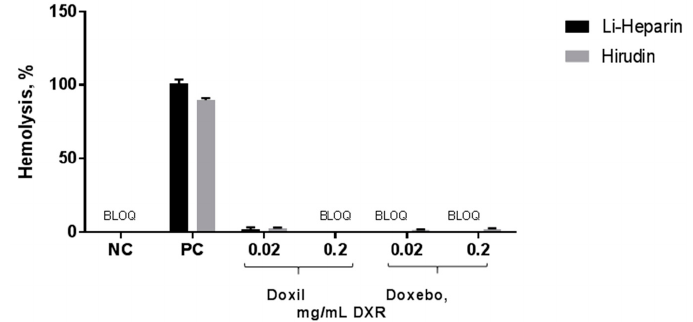
Figure 2. Hemolysis assay. Various, clinically relevant concentrations of Doxil and Doxebo were tested in the hemolysis assay in order to estimate their potential effects on the integrity of red blood cells. Three independent samples were prepared for each nanoparticle concentration and analyzed in duplicate (%CV < 20). Shown is mean ( n = 3) ± SD. Triton X-100 was used as a positive control (PC). PBS was used as the negative control (NC). BLOQ: Below limit of